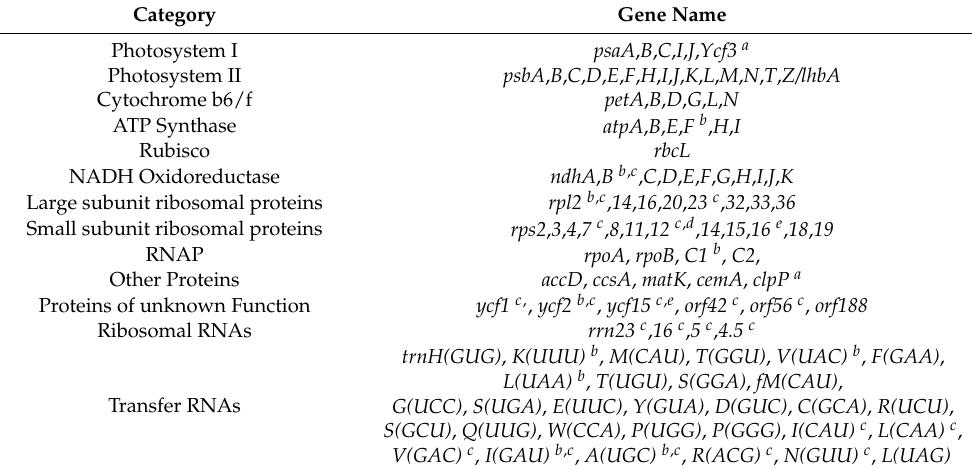
Table 2. List of genes present in the Cp genome of clusterbean.